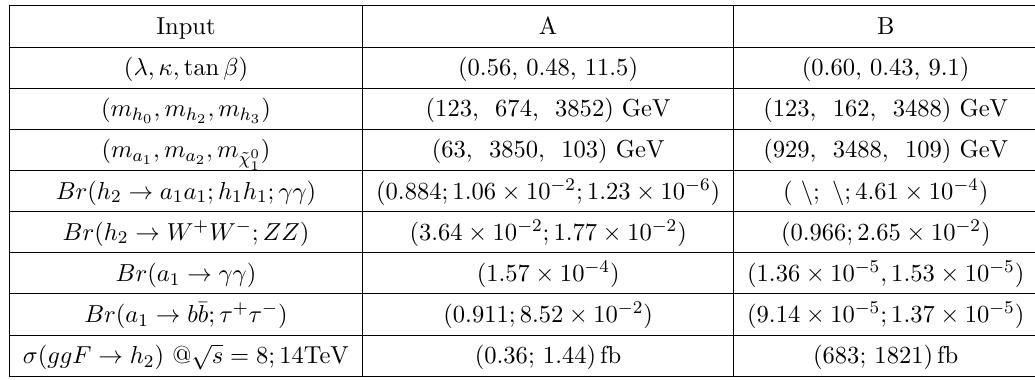
Table 1 . Two benchmark points with the corresponding branch ratio for h 2 ; a 1 and gluon fusion cross section for h 2 at